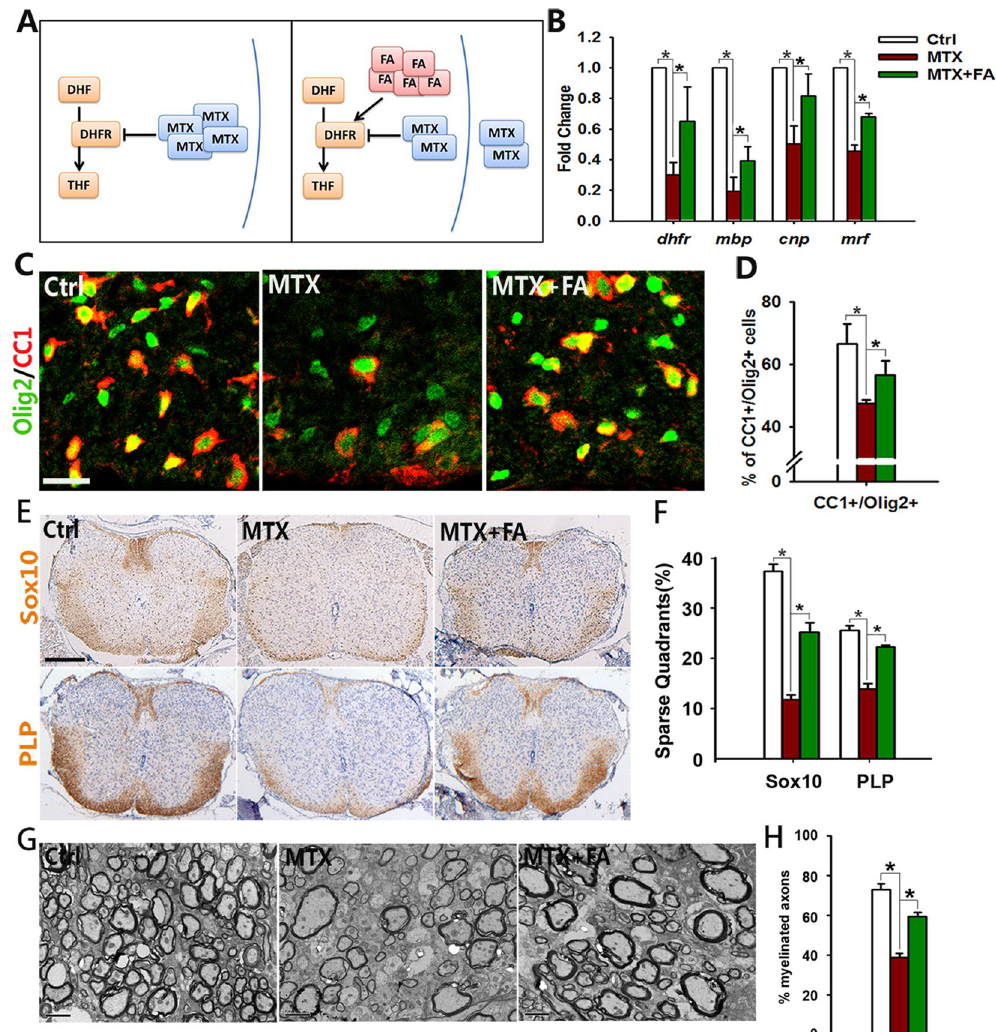
Figure 6. Oligodendrocyte defects induced by DHFR inhibition could be rescued by folate supplement. ( A ) Diagram shows the competition of folate and MTX on DHFR. Folate can block MTX entering cells by competitive combination of membrane receptor, leading to the reduction of DHFR inhibition. ( B ) qRT-PCR is carried out to analyze mRNA level of Dhfr , Mbp , Cnp , Myrf of spinal cords form control, MTX (4 mg/kg) and MTX (4 mg/kg) plus folate (10 mg/kg) mice at P8. Data represents the mean ± S.D. (n > 3, * p < 0 . 05 , one-way ANOVA). ( C ) Immunostaining using antibodies of Olig2, CC1 on spinal cord from control, MTX (4 mg/kg) and MTX (4 mg/kg) plus folate (10 mg/kg) mice at P8. The ventral parts showed in the images. ( D ) Quantification of the percentage of CC1 + cells among Olig2 + cells in ( C ). Data represents the mean ± S.D. (n = 5, * p < 0 . 05 , one-way ANOVA). ( E ) Immunohistochemistry using antibodies of Sox10 and PLP on spinal cord from control, MTX (4 mg/kg) and MTX (4 mg/kg) plus folate (10 mg/kg) mice at P8. ( F ) The number of quadrants with sparse staining for Sox10 and PLP in ( E ) scored and expressed as a percentage of the total number of quadrants. (n = 5, * p < 0 . 05 , one-way ANOVA). ( G , H ) Electron micrographs of spinal cord from control, MTX (4 mg/kg) and MTX (4 mg/kg) plus folate (10 mg/kg) mice at P15. ( H ) Shows the percentage of myelinated axons. Data represent the mean ± S.E.M from three animals ( * p < 0 . 05 , one-way ANOVA). Scale bars: 50 μ m ( C ), 200 μ m ( E ), 2 μ m ( G